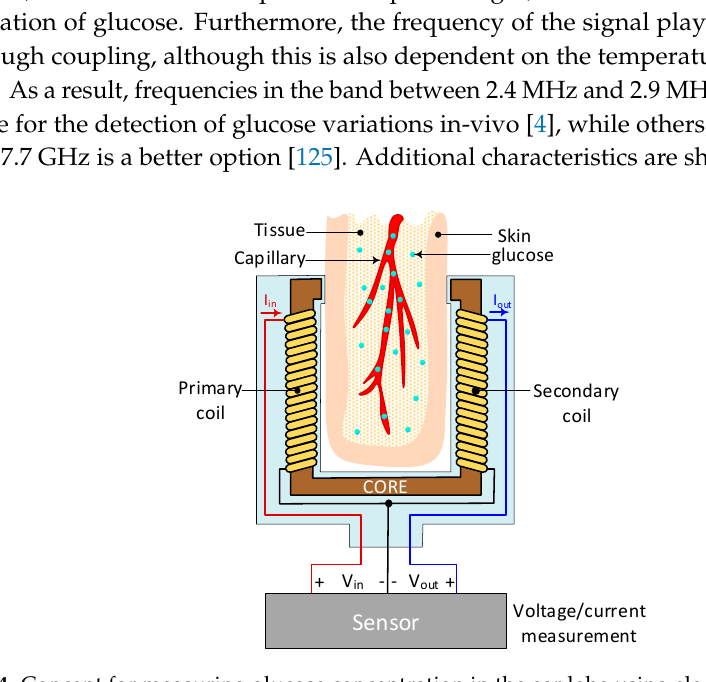
Figure 14. Concept for measuring glucose concentration in the ear lobe using electromagnetic sensing. Table 18. Advantages and disadvantages of electromagnetic sensing